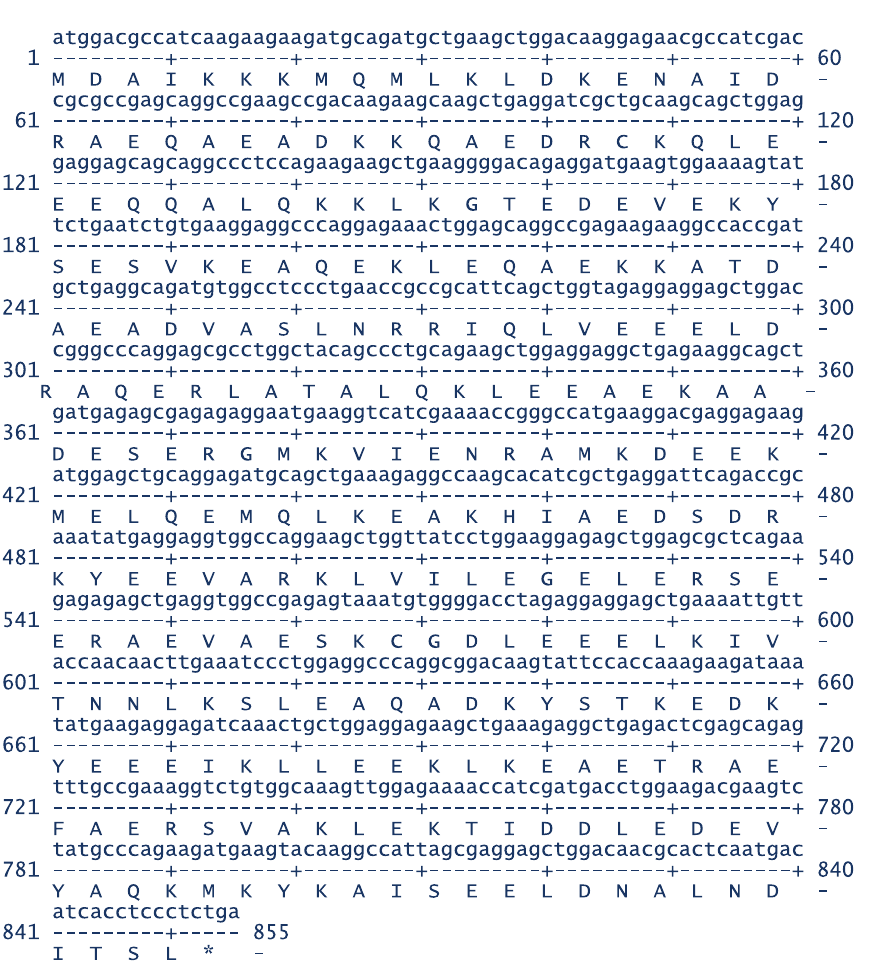
Figure 2: Nucleotide sequence of Cyn heart TPM2a cDNA and its deduced amino acid